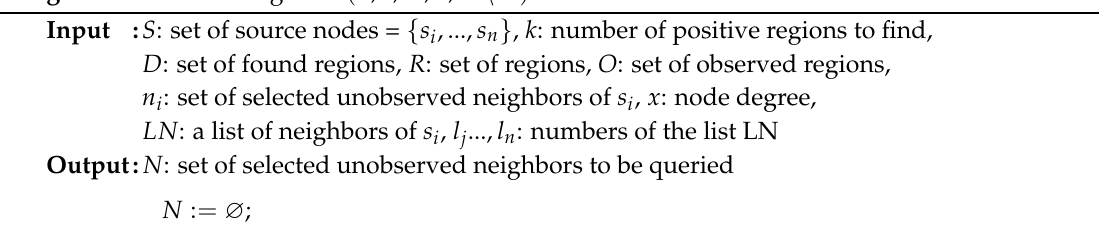
Algorithm 9: selectNeighbors ( S , k , D , x , R \ O